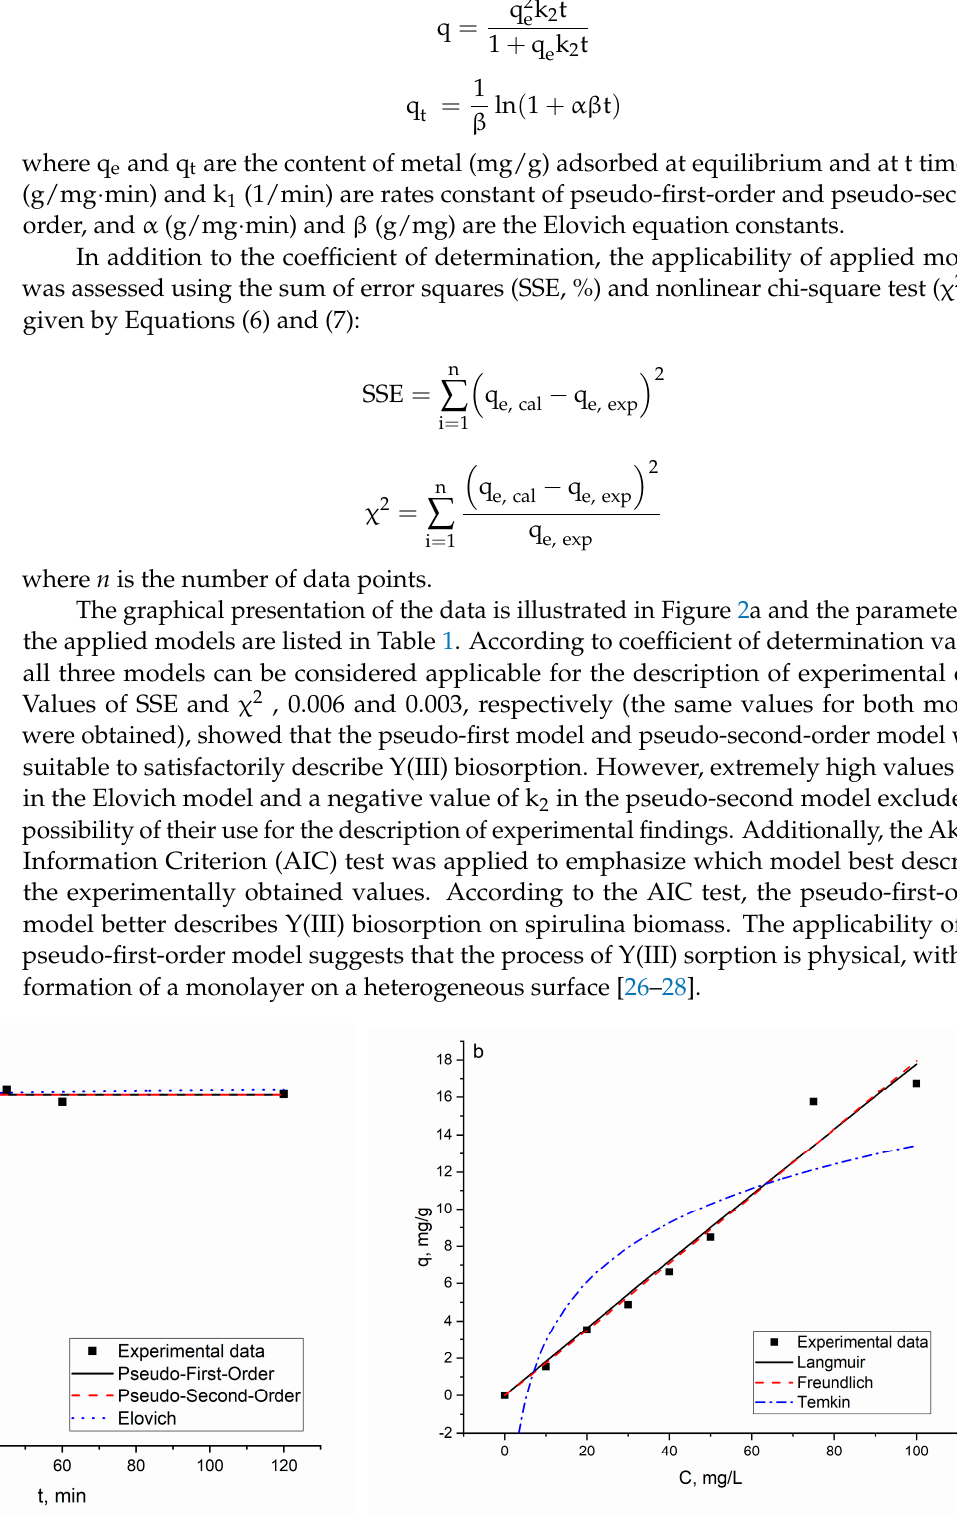
Figure 2. ( a ) Kinetics and ( b ) isotherms of Y(III) biosorption on A. platensis biomass.